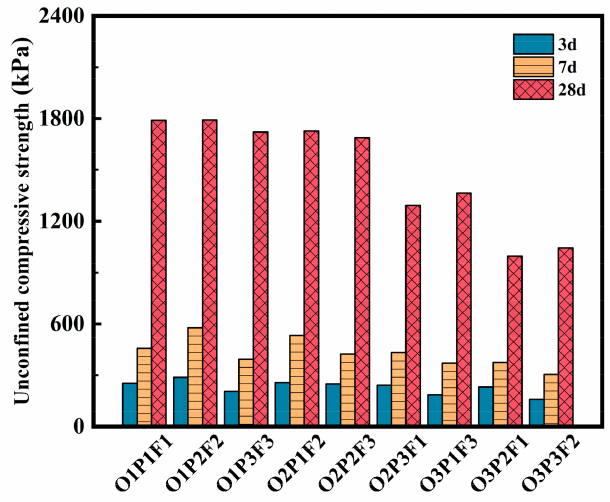
Figure 4. Unconfined compressive strength of solidified soil at different curing